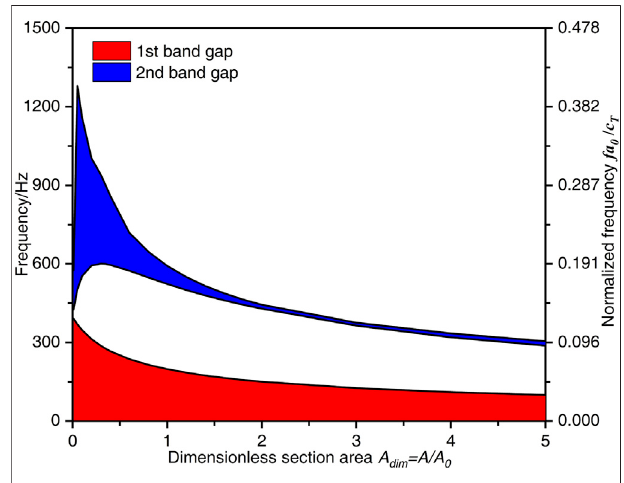
FIGURE 9 | The fl exural wave band gaps characteristics with different dimensionless section area Adim